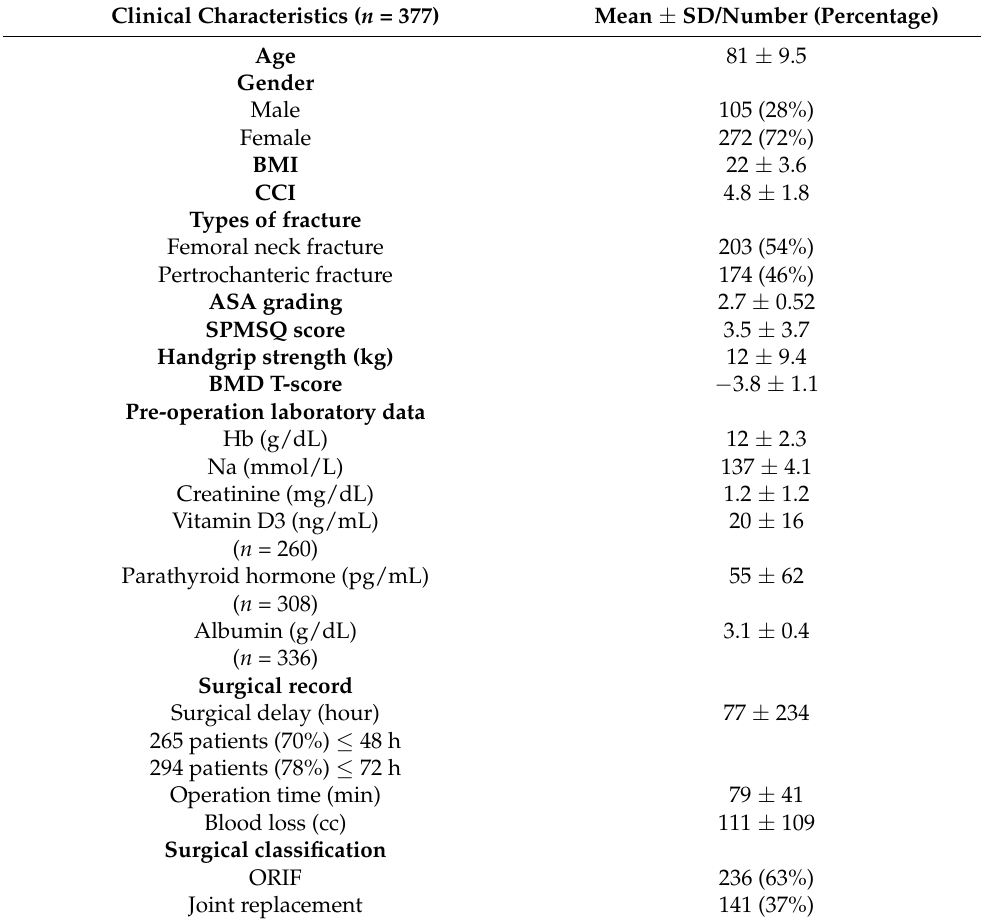
Table 1. Baseline clinicodemographic characteristics of the study population. Clinical Characteristics ( n =